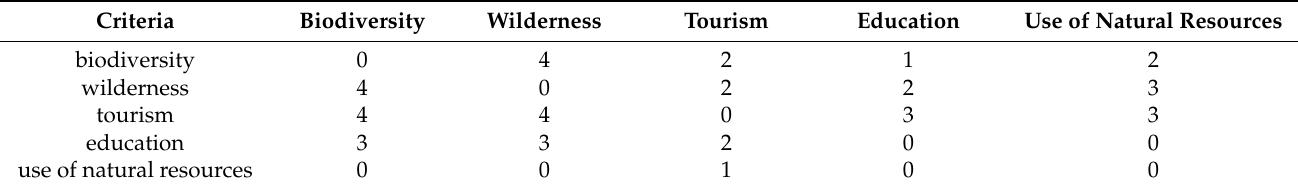
Table 3. DEMATEL direct influence matrix—assessments of criteria.